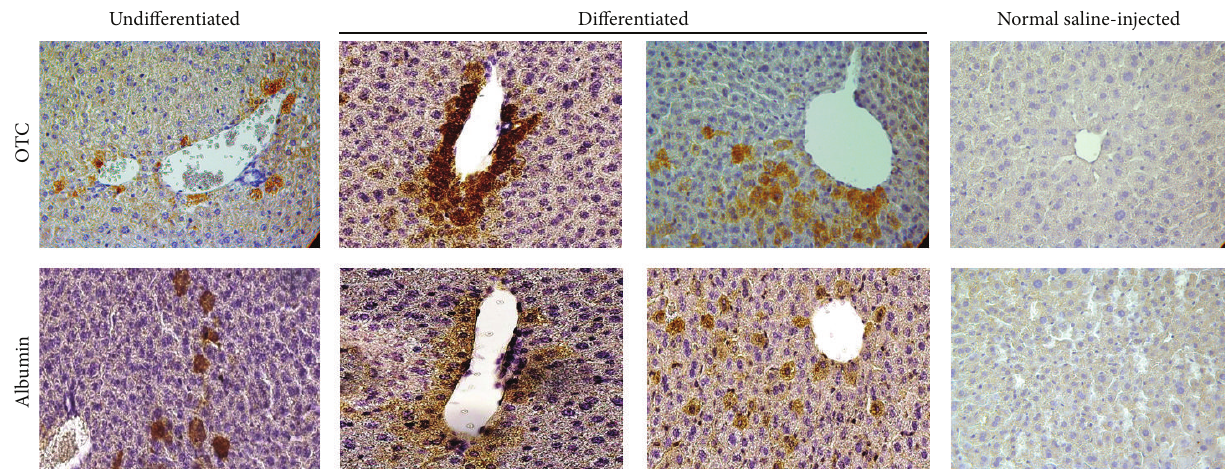
Figure 6: Engraftment and in situ differentiation of FL-MSCs in intrahepatically transplanted NOD/SCID mice. OTC (ornithine transcarbamylase, upper panel) and human albumin (lower panel) immunohistochemistry in liver sections from NOD/SCID mice intrahepatically infused with undifferentiated or differentiated FL-MSCs. Analyses were performed at 8 weeks after transplantation and revealed the presence of both integrated scattered cells and clusters of cells expressing both human albumin and OTC, mainly close to vascular structures. Negative control: normal saline-injected mice. Magnification